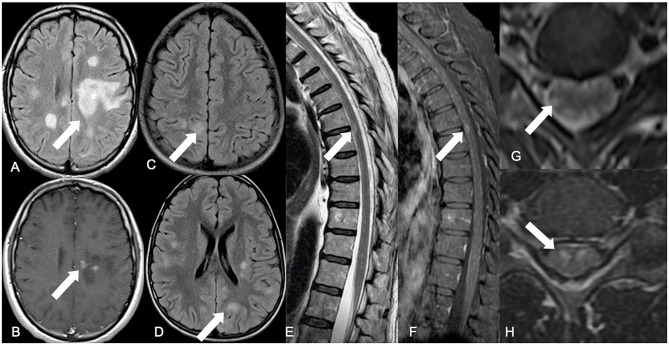
Summary of main neuroimaging findings. Brain axial FLAIR showing a tumefactive hyperintense lesion located in the frontal-parietal transition of the left hemisphere (white arrow) (A), with punctate discontinued contrast enhancement on the corresponding axial post-contrast T1-WI (white arrow) (B), representing an ADEM pattern. An encephalitis pattern can be seen on brain FLAIR axial images (white arrows) with cortical-subcortical hyperintense diffuse lesions (C,D). Dorsal spinal cord sagittal T2-WI with elongated areas of peripherally located hypersignal intensity among the white matter tracts (white arrow) (E), associated with contrast enhancement on sagittal FS T1-WI (white arrow) (F). Axial T2-WI have elongated hypersignal images in a radial distribution, from the central spinal cord gray matter to the peripheral white matter (white arrow) (G). Axial T2-WI with hypersignal affecting the gray matter anterior horn, in a polio-like pattern (white arrow) (H).